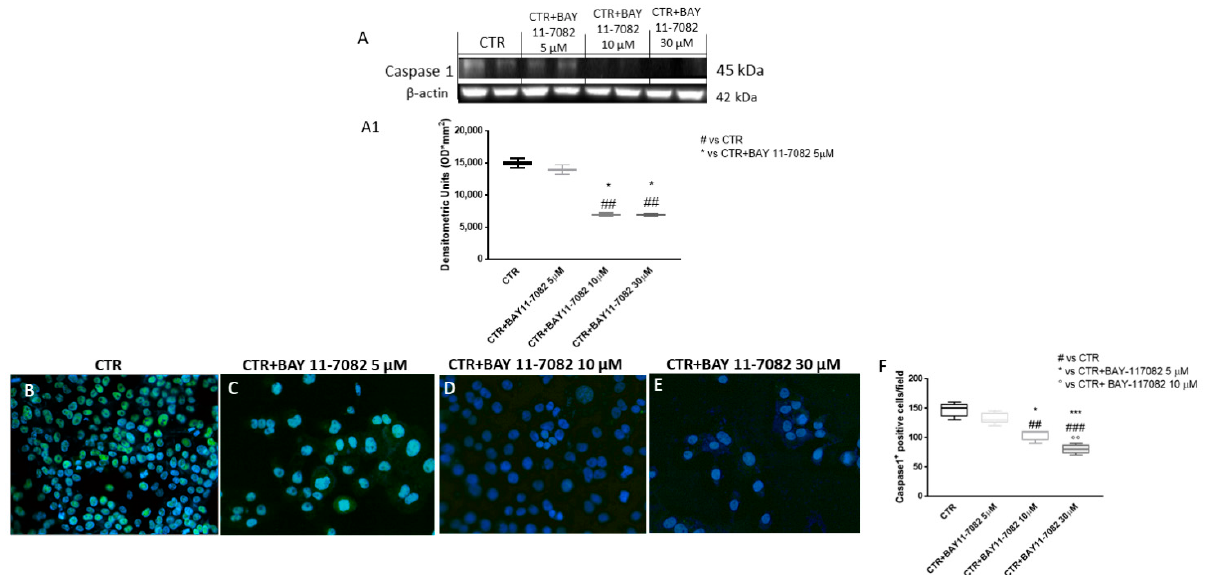
Figure 3. ( A – E ) Effect of BAY-117082 on caspase-1 expression. Blots reveal that BAY-117082 treatment at concentrations of 10 and 30 µM was able to reduce caspase-1 expression compared to control group. ( F ) Data were also confirmed by immunofluorescence assay. Data are representative of at least three independent experiments. ( A ) ## p < 0.01 vs. CTR; * p < 0.05 vs. CTR + BAY-17082 5 µM. ( F ) ## p < 0.01 vs. CTR; ### p < 0.001 vs. CTR; * p < 0.05 vs. CTR + BAY-17082 5 µM; *** p < 0.001 vs. CTR + BAY-17082 5 µM; °° p < 0.01 vs. CTR + BAY-117082 10 µM.